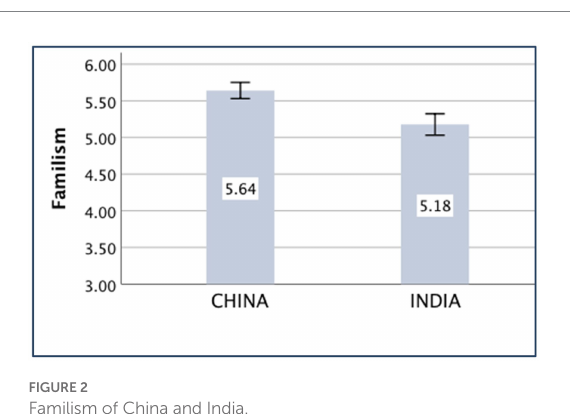
FIGURE 2 Familism of China and